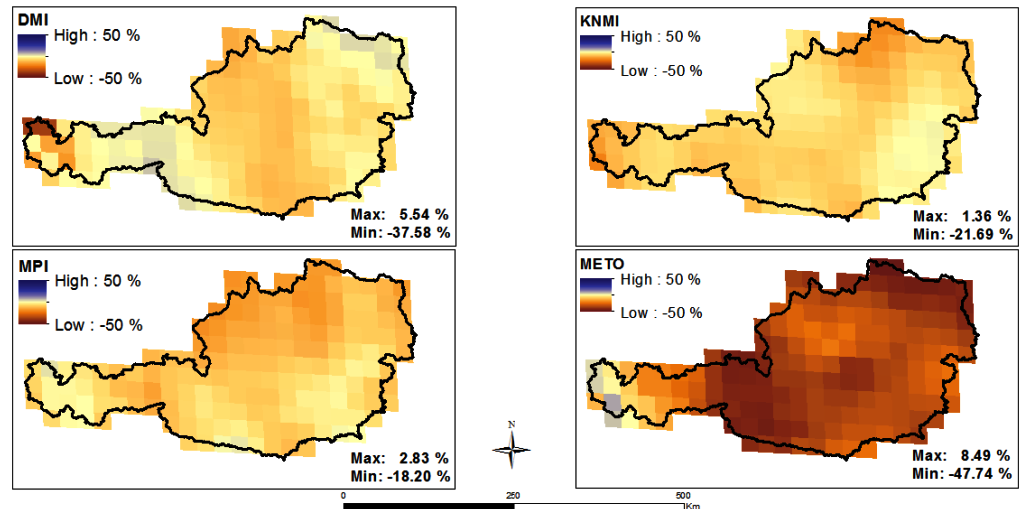
Figure 3. Percentage difference of mean snowfall in the winter season between the periods 1961–1990 and 2011–2040.